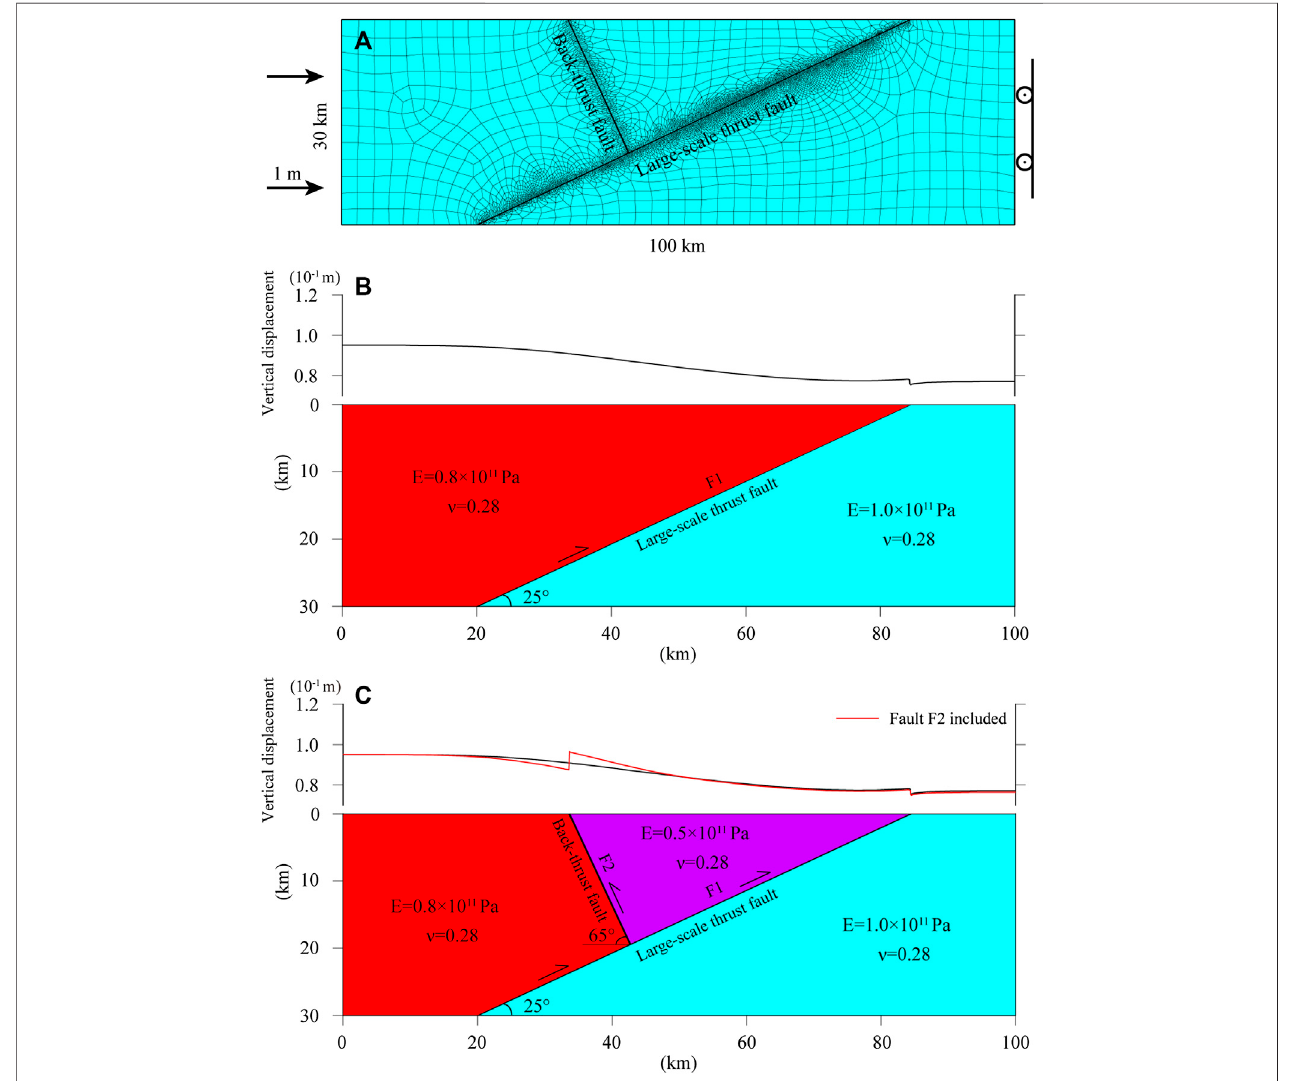
FIGURE 8 | Schematic model of the impact of fault systems on the vertical surface deformation. (A) The 2D elastic fi nite element model. (B) The projected vertical surface deformation with only the large-scale thrust fault included. (C) The projected vertical surface deformation where both fault systems are included. The fault has Young ’ s modulus (E) of 0.5 × 10 10 Pa and Poisson ratio ( ν ) of 0.3.